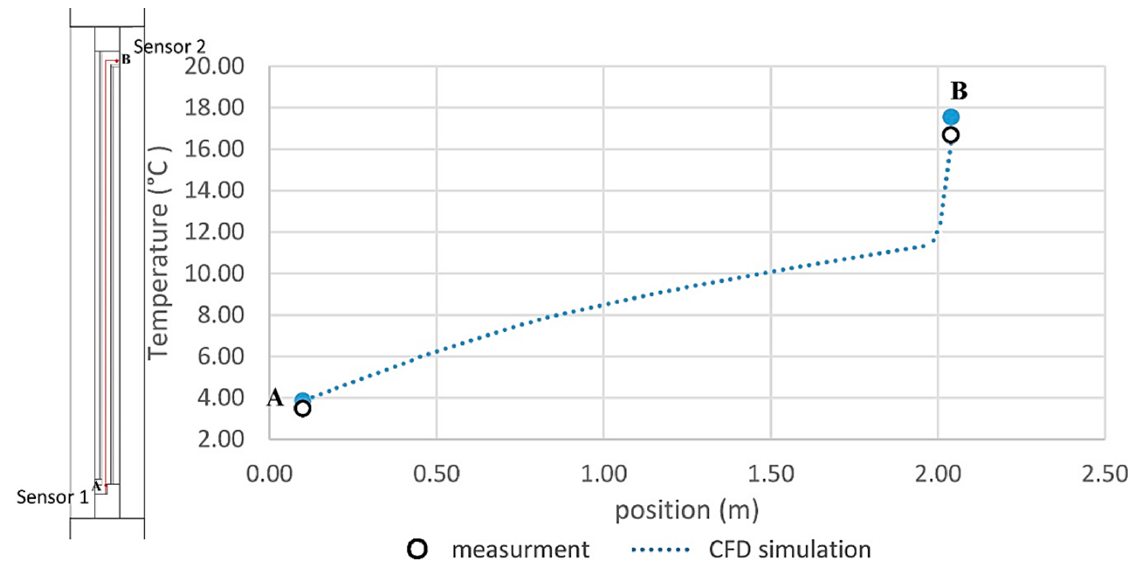
Figure 8. Left: Schematic section through the examined ventilated window with the position of the two temperature probes (used in the course of field measurements); right: Measured (sensors A and B ) and simulated temperature profiles.